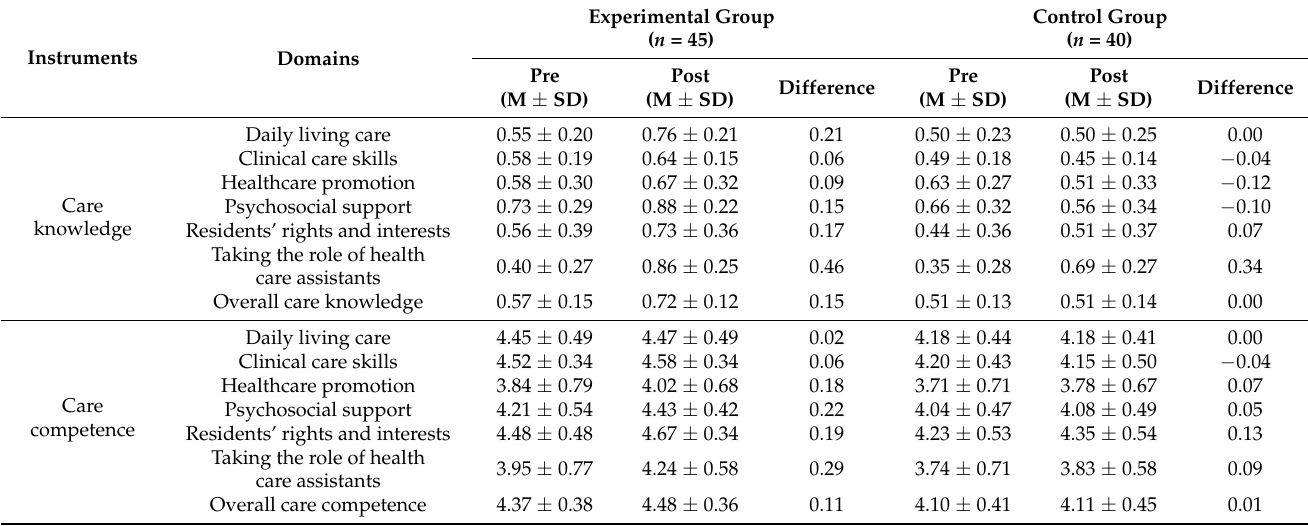
Table 3. Means and standard deviations of care knowledge and care competence.